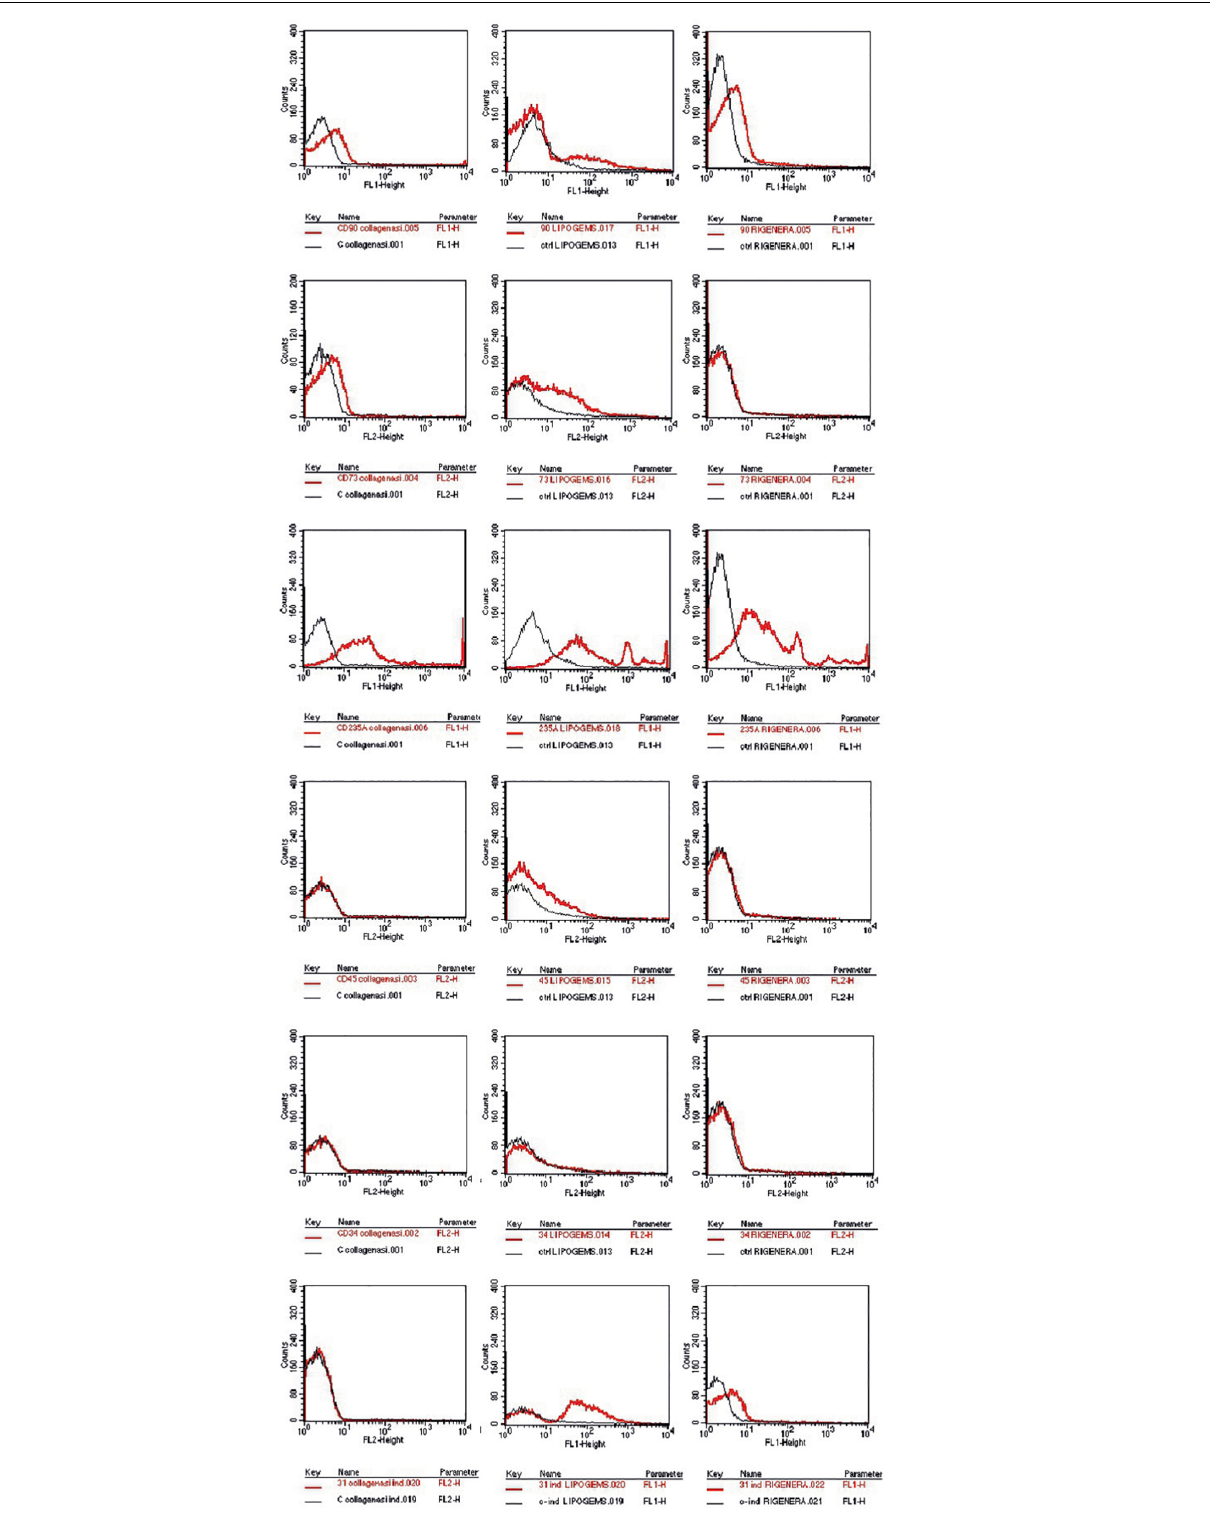
FIGURE 2 | CD expression marker of one sample chosen randomly, showed as exemplification. In the first column the enzymatic technique reveals CD90, 73, 235a+, and CD45, 34, 31–. For the mechanical techniques, in the second Lipogems system CD90, 73, 235a, 45, 31+, and CD34–. Rigenera system in the last column CD90+, 73–, 235a+, and CD45–, 34–, 31+.